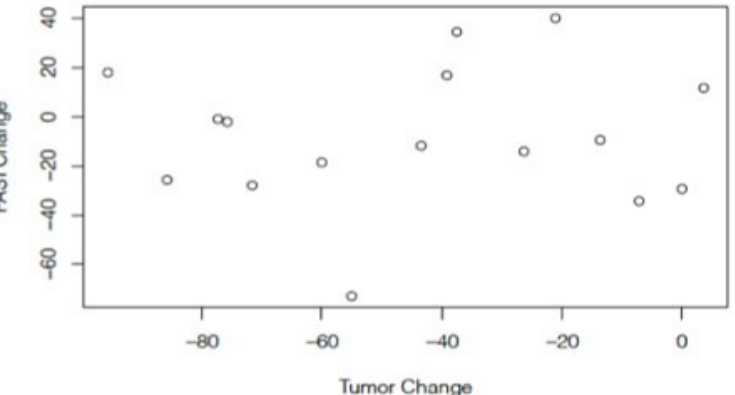
Figure 3. Comparison of the change in FASI to the change in the LGG size at paired time points did not show any correlation.